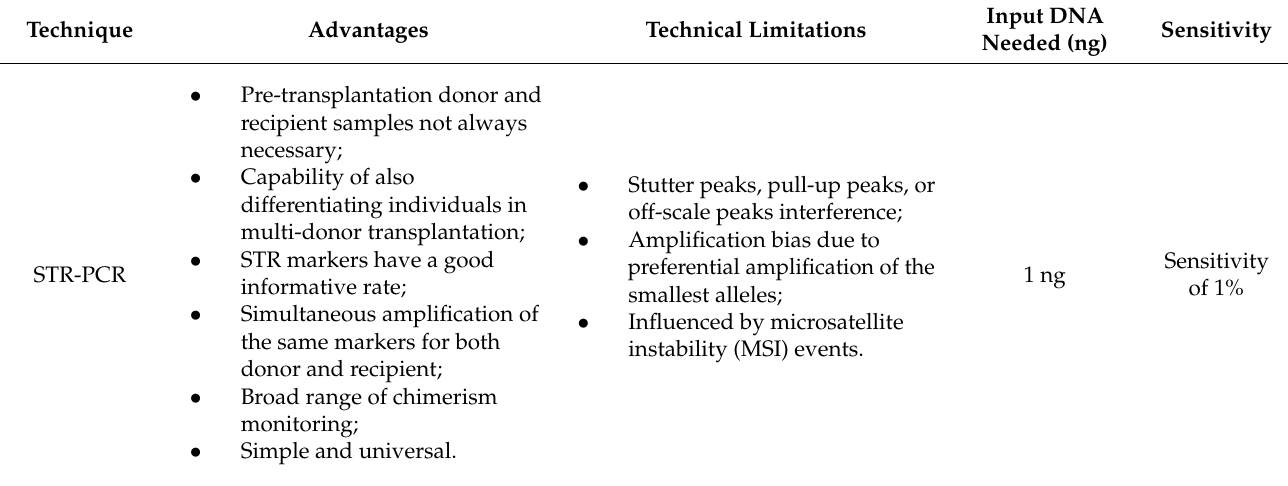
Table 1. Comparison among the molecular biology techniques currently available for chimerism monitoring: short tandem repeats (STR)-PCR [18,26,29,31,34–37,41,43,47,49,50,53]; quantitative PCR (qPCR) [9,17,18,31,34,38,47,49,50,55]; digital PCR (dPCR) [12,26,31,38,40,47,49,53,58]; and NGS [10,31,33,45,47,60,61]. Technique Advantages Technical Limitations